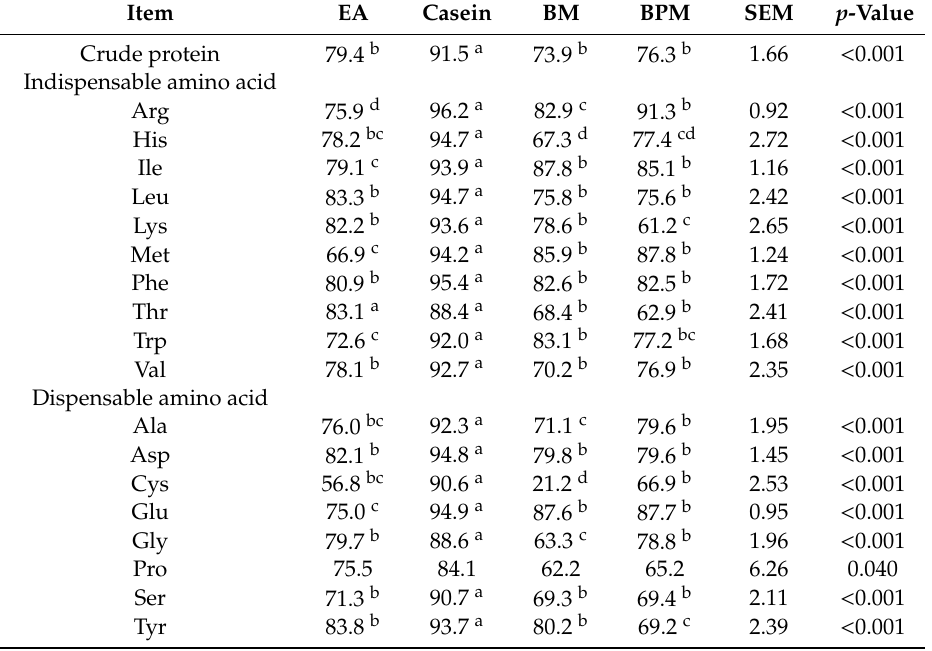
Table 5. Apparent ileal digestibility (%) of crude protein and amino acids for experiment 1 1,2 . Item EA